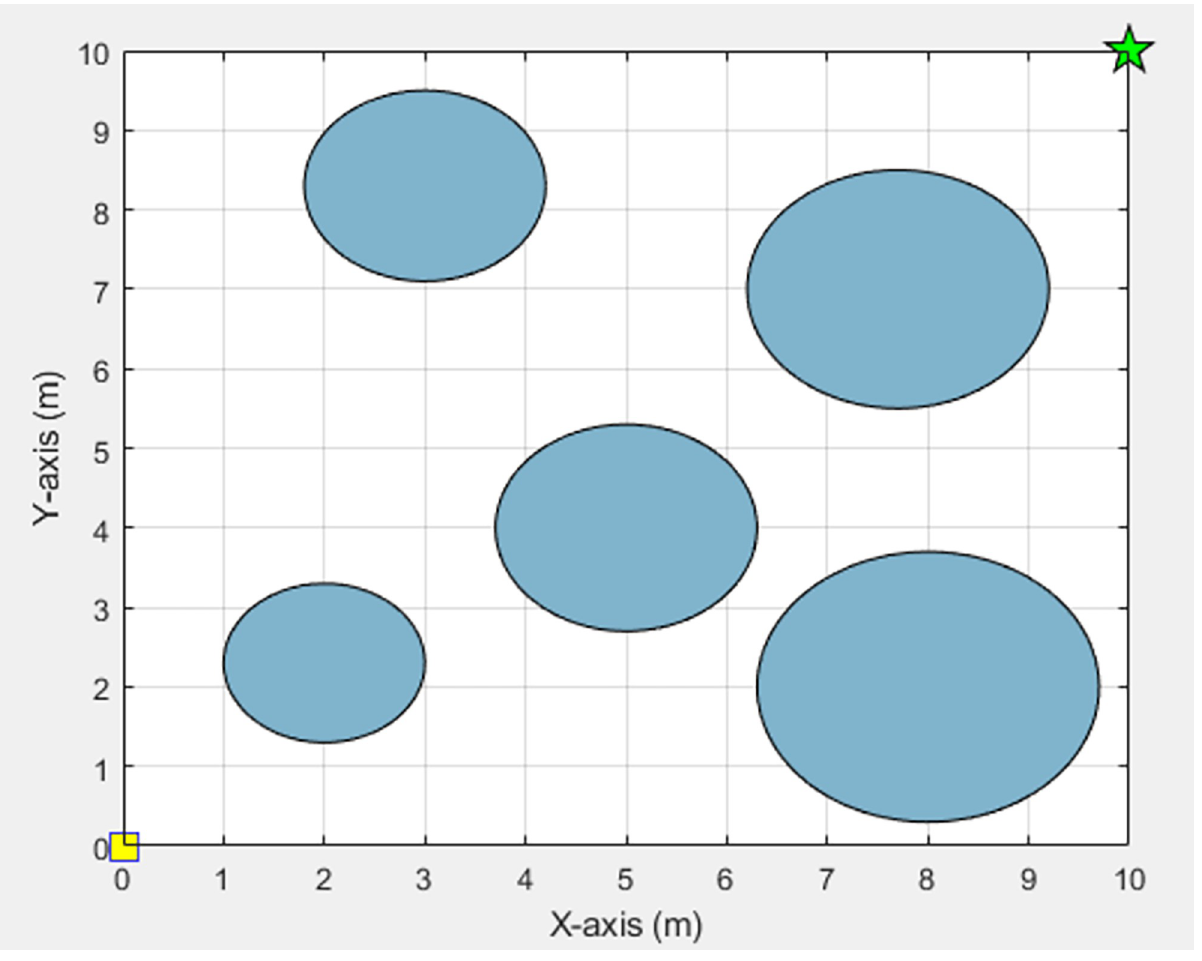
Fig 10. Example of the traveling environment. circles. The starting point is represented with a yellow square, and the destination is repre- sented with a green star. Their positions are determined on the table by the requirements of each experiment. An example of the traveling environment is shown in Fig 10. Procedure 2—Particle generation: Randomly generate initial population. In this procedure, nPop initial particles are created. They are the determined position values and velocity with randomization. Various values are determined for each particle as follows: X it is the position of j particle j in iteration it, V it is the velocity of particle j in iteration it, Pbest it is the best position j j of particle j in iteration it, and F ( X ) is the fitness value of the particle where j = 1, 2, . . . , nPop j is a sequence of particles, it = 1, 2, . . . , Maxit is the number of iterations of the algorithm. Procedure 3—Mutation: After each particle is created, Mutant Particle M will be created by j the following equation: ¼ X it þ F � ð X it (cid:0) X it Þ ð 11 Þ M it j r i 1 r i 2 r i 3 where M it is the mutant particle in iteration it, r i ; r i ; and r i is a randomly selected integer in 1 2 3 j